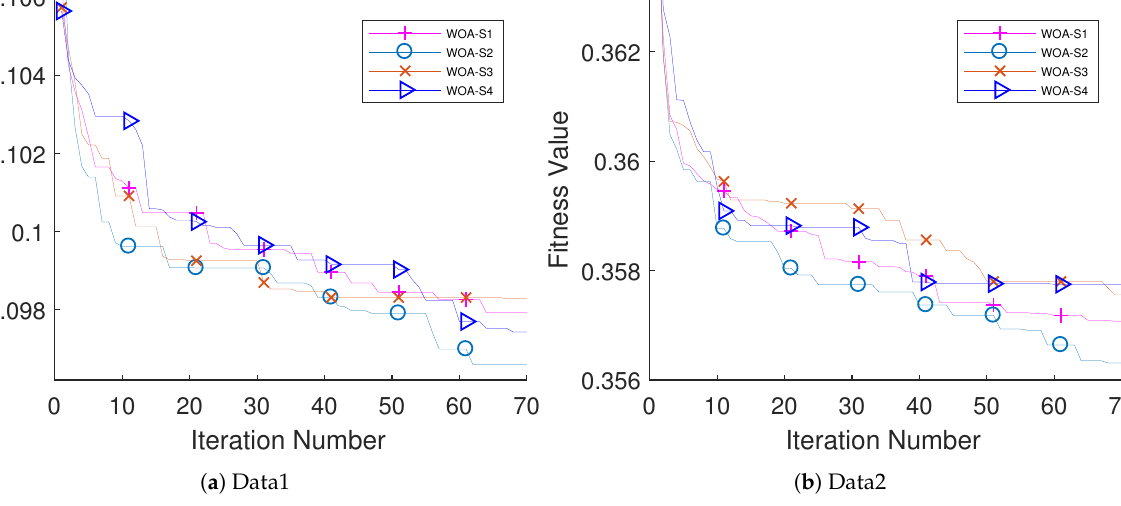
Figure 13. Convergence curves of WOA with different S-shaped TFs.